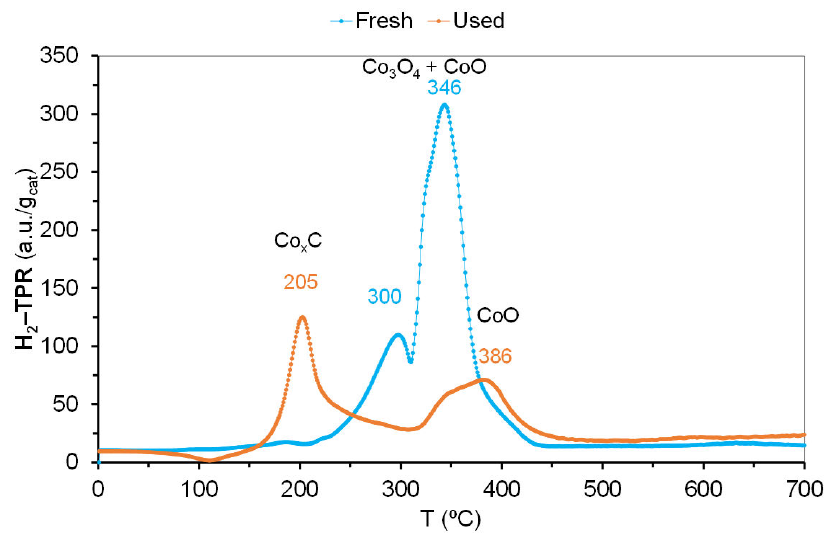
Figure 10. Comparison of H 2 -TPR obtained before and after reaction for cobalt–cerium bimetallic oxides catalysts pre-treated under hydrogen obtained by the Electrospinning